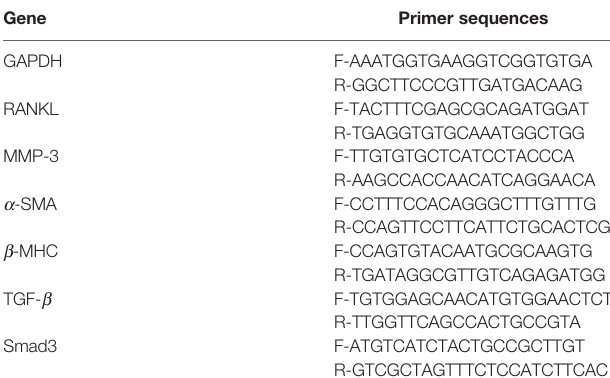
TABLE 1 | qRT-PCR primer